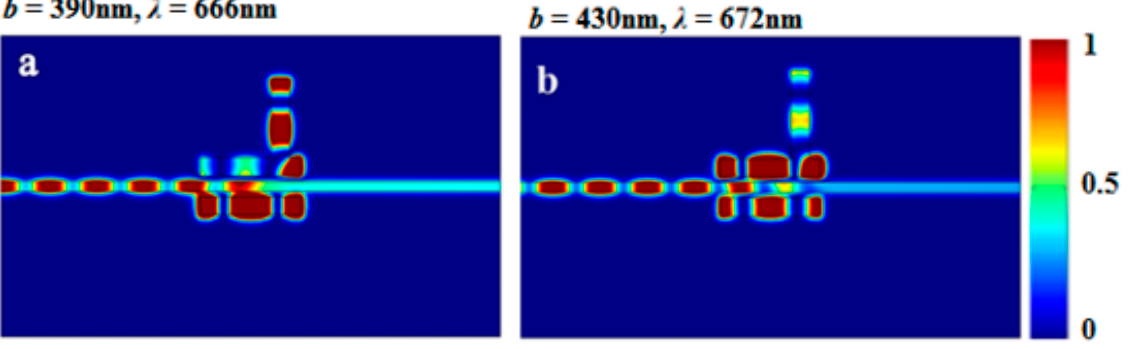
Figure 12. ( a ) The field distribution | H z | 2 of the structure at ( a ) incident wavelength 666 nm when b = 390 nm; ( b ) incident wavelength 672 nm when b = 430 nm.